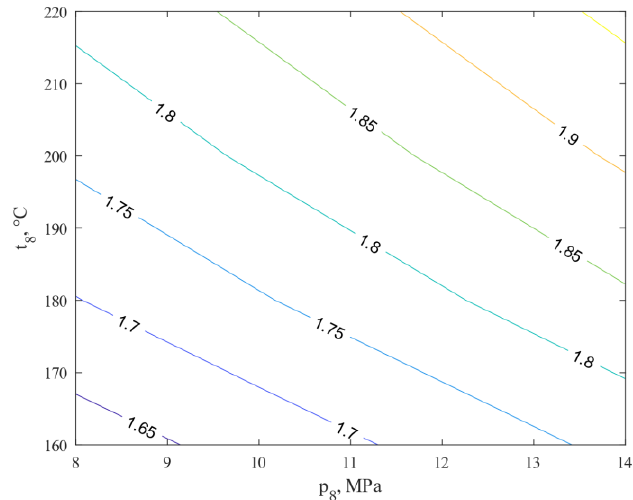
Figure 4. Influence of changes in pressure p 8 and temperature t 8 at the reactor inlet (Figure 3) on the power of the gas turbine N T in kW.